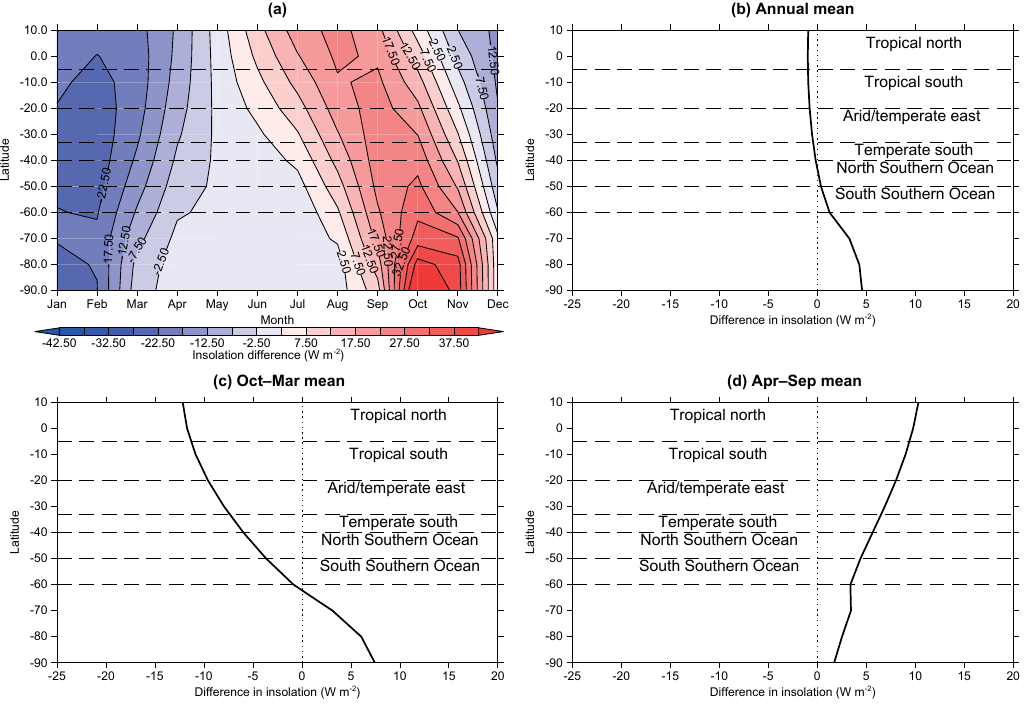
Figure 2. The difference in (a) the zonal, seasonal insolation (Wm − 2 ) at the top of the atmosphere for 6ka relative to 0ka as used by the PMIP2 and PMIP3 models between 10 ◦ N and 90 ◦ S. The difference in (b) the annual, (c) October to March and (d) April to September zonal mean insolation (Wm − 2 ) at the top of the atmosphere between 10 ◦ N and 90 ◦ S.